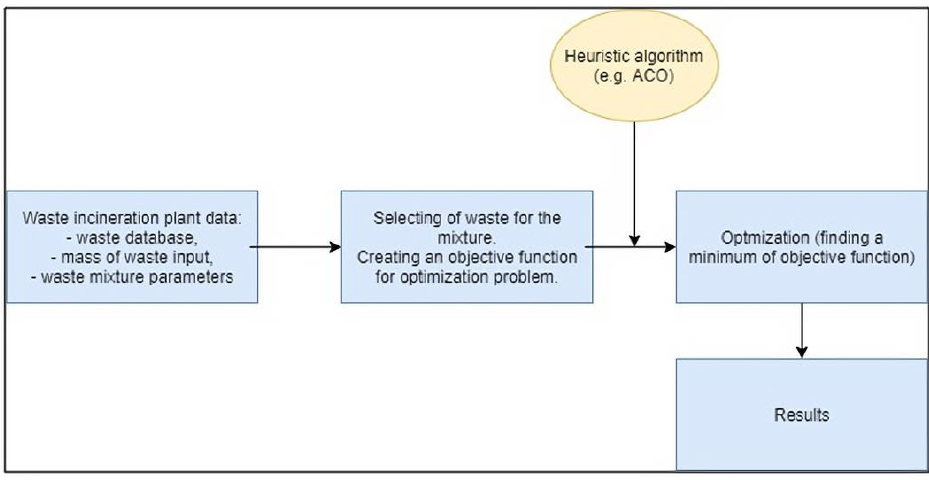
Figure 1. General scheme of the application model.